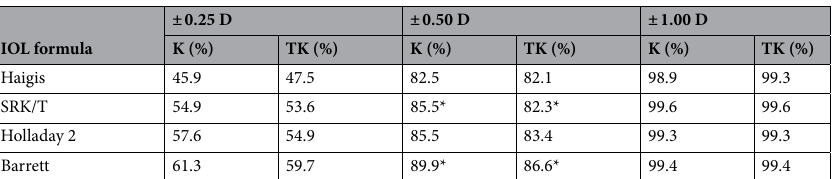
Table 3. Proportion of eyes within ± 0.25 D, ± 0.50 D, and ± 1.00 D of spherical equivalent prediction error. D diopters, K conventional keratometry, TK total keratometry. *Statistically significant difference between the K and